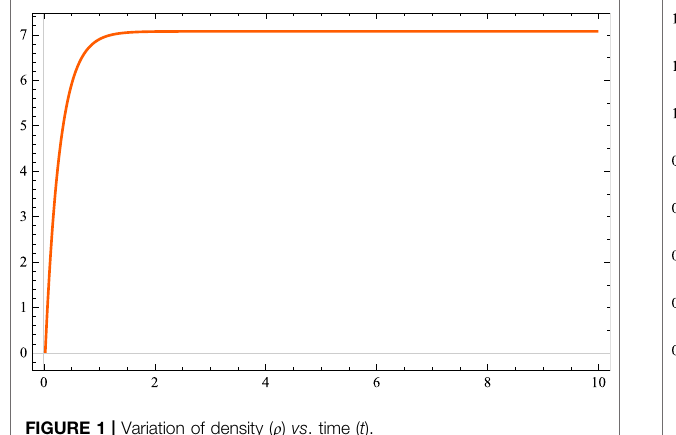
FIGURE 1 | Variation of density ( ρ ) vs . time ( t ).